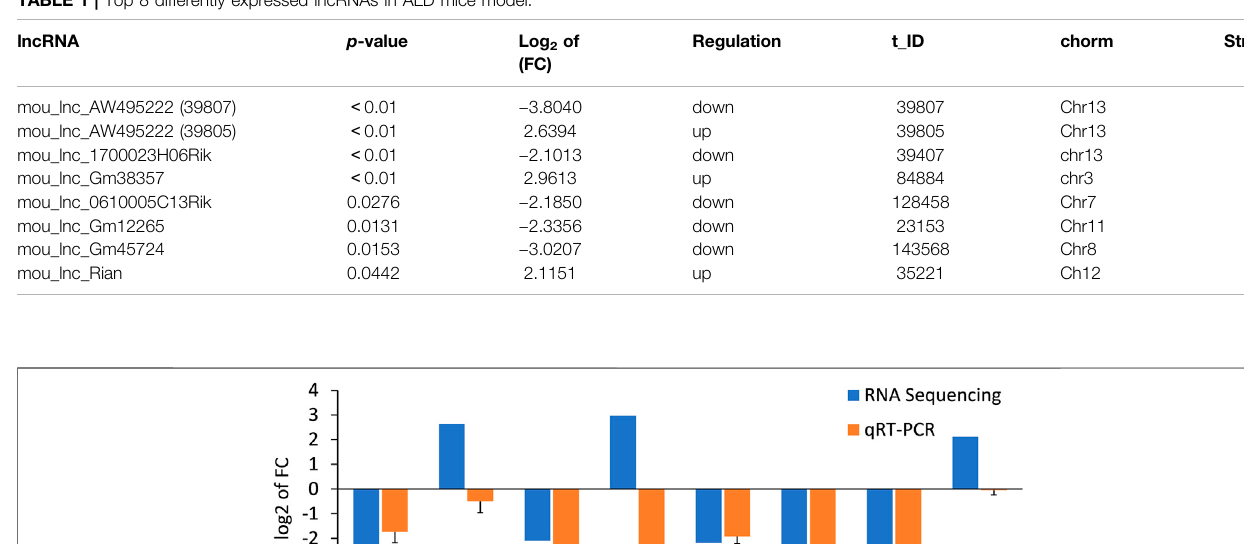
TABLE 1 | Top 8 differently expressed lncRNAs in ALD mice model.